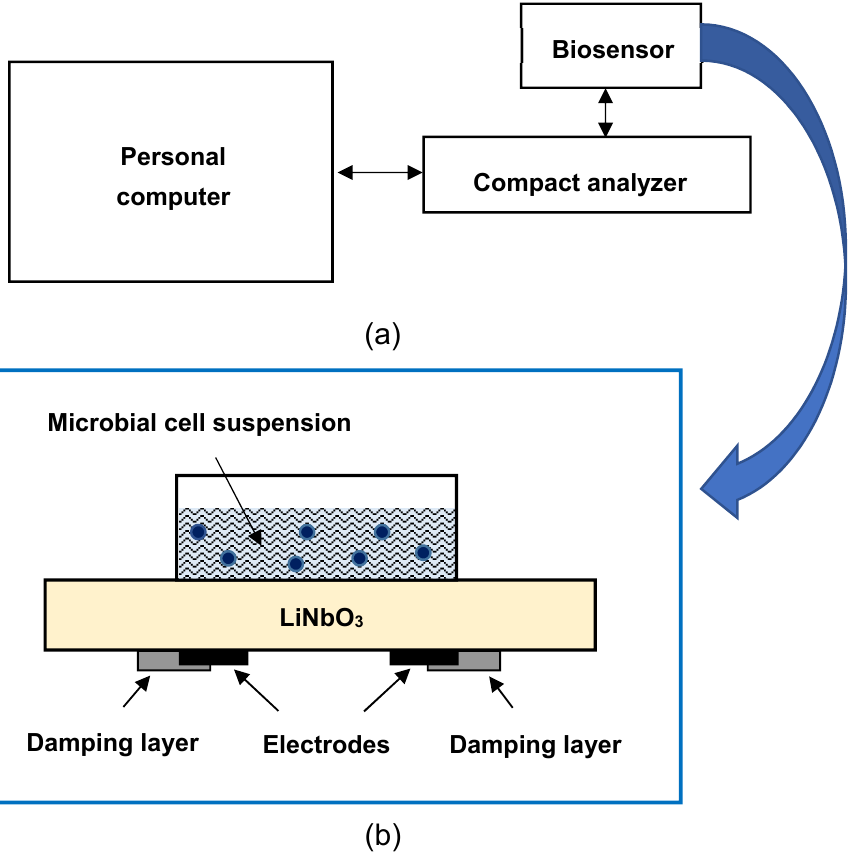
Figure 3. ( a ) The scheme of compact acoustic analyzer for antibiotic analysis in aqueous solutions; ( b ) the sensor based on a resonator with a lateral electric field with a liquid container.